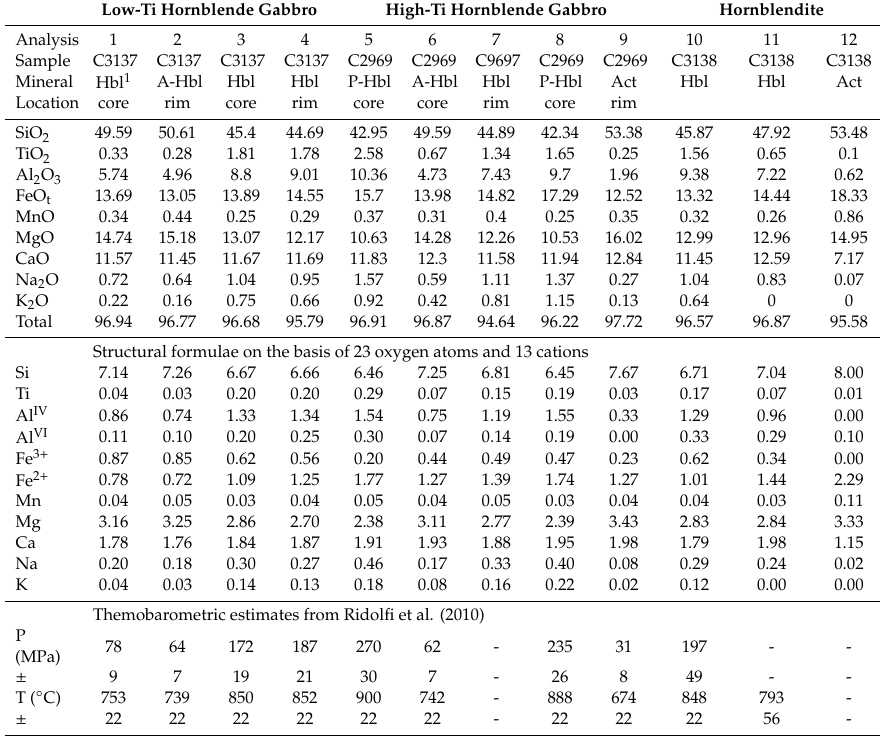
Table 1. Representative analyses of the amphibole by electron